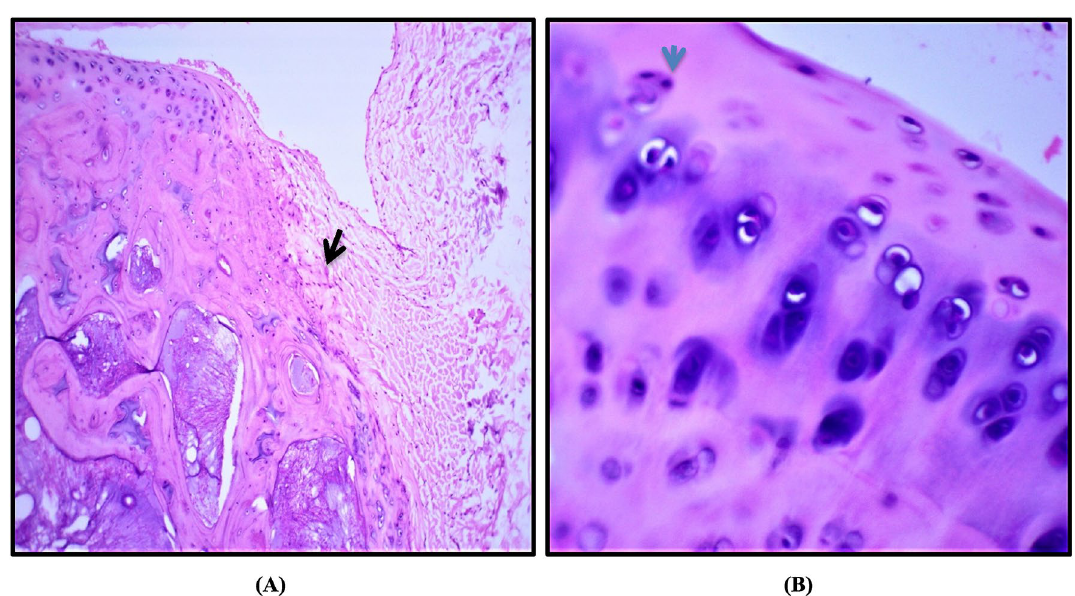
Figure 9. Photomicrographs illustrating the lesions resulting from HFD. ( A ) Fibrillation and fissuring of articular cartilage progressed to erosion of non-calcified cartilage was shown (black arrow) and the tidemark is no longer intact. Magnification × 10. ( B ) Most of chondrocytes were highly destructed with no clear lacunae (blue arrow) and pyknotic nuclei was also observed. Magnification ×